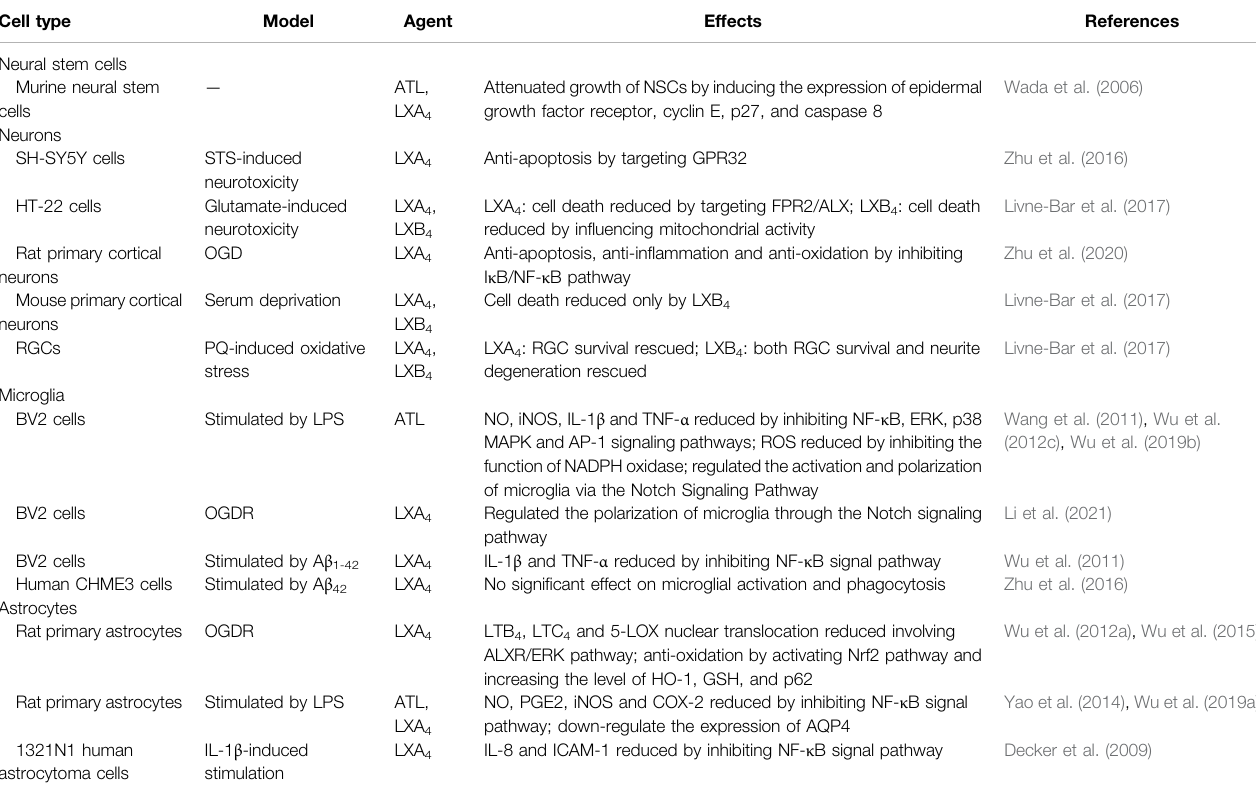
TABLE 1 | Summary of in vitro studies on the neuroprotective effects of lipoxins. Cell